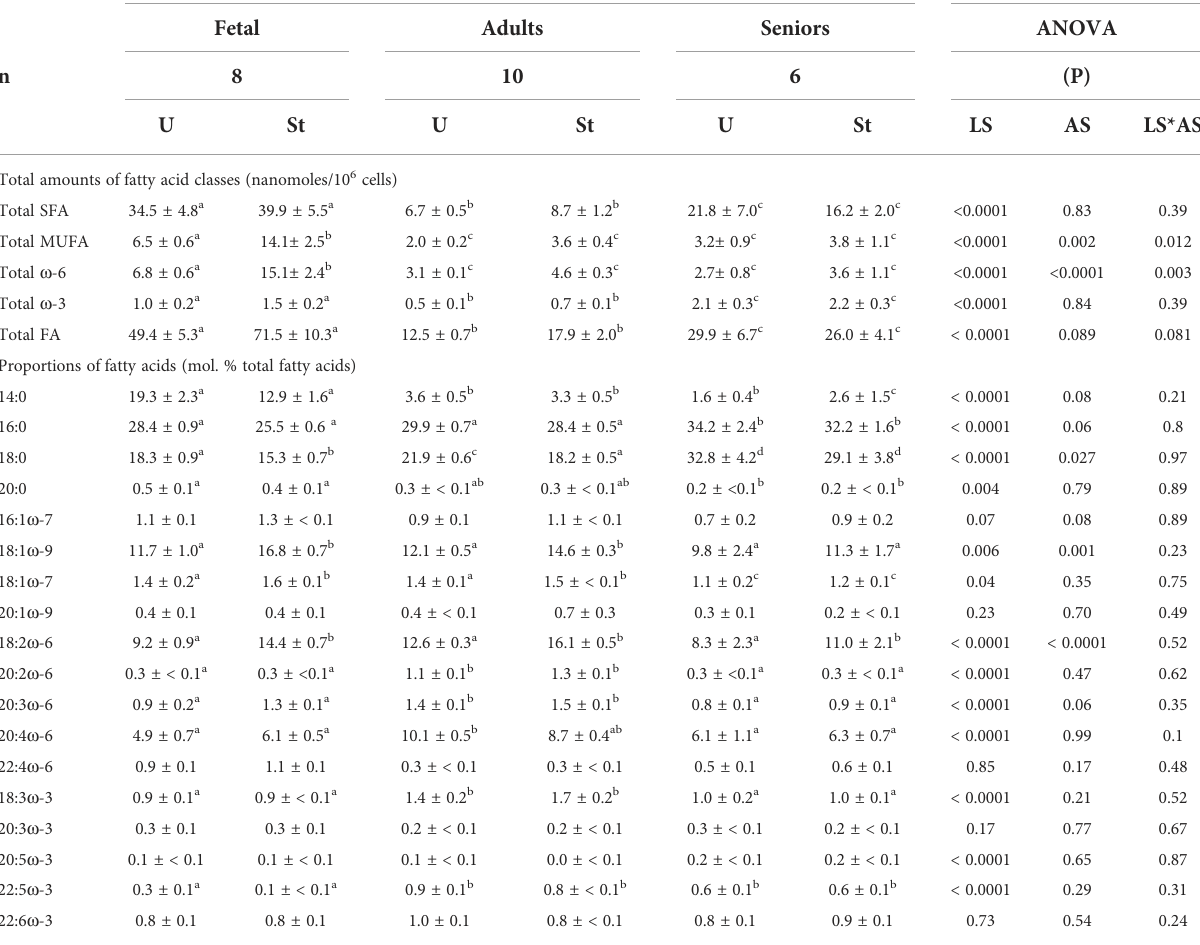
TABLE 1 Effect of life stage on activation-associated changes in the fatty acid composition of T lymphocytes. Fatty acid composition by life stage and activation state Fetal Adults Seniors ANOVA